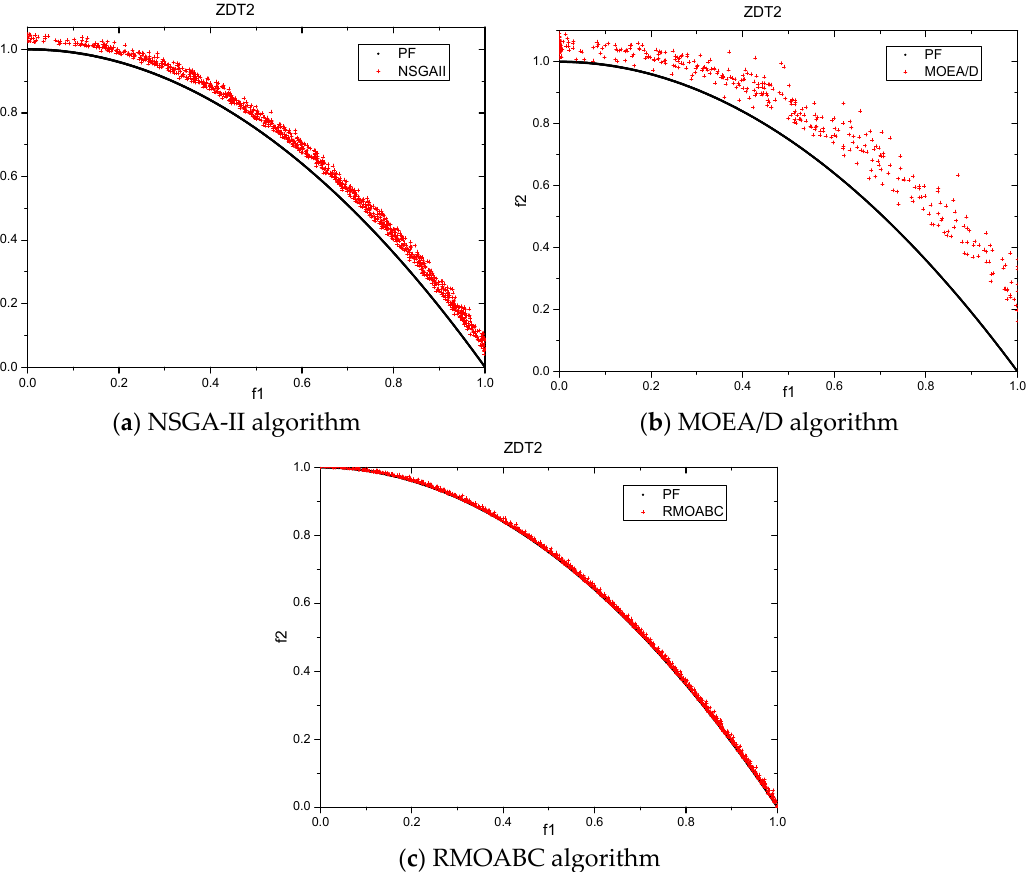
Figure 3. Plots of the non-dominated front found by the three algorithms for 2-objective ZDT2 test instance. ( a ) NSGA-II algorithm; ( b ) MOEA/D algorithm; ( c ) RMOABC algorithm.